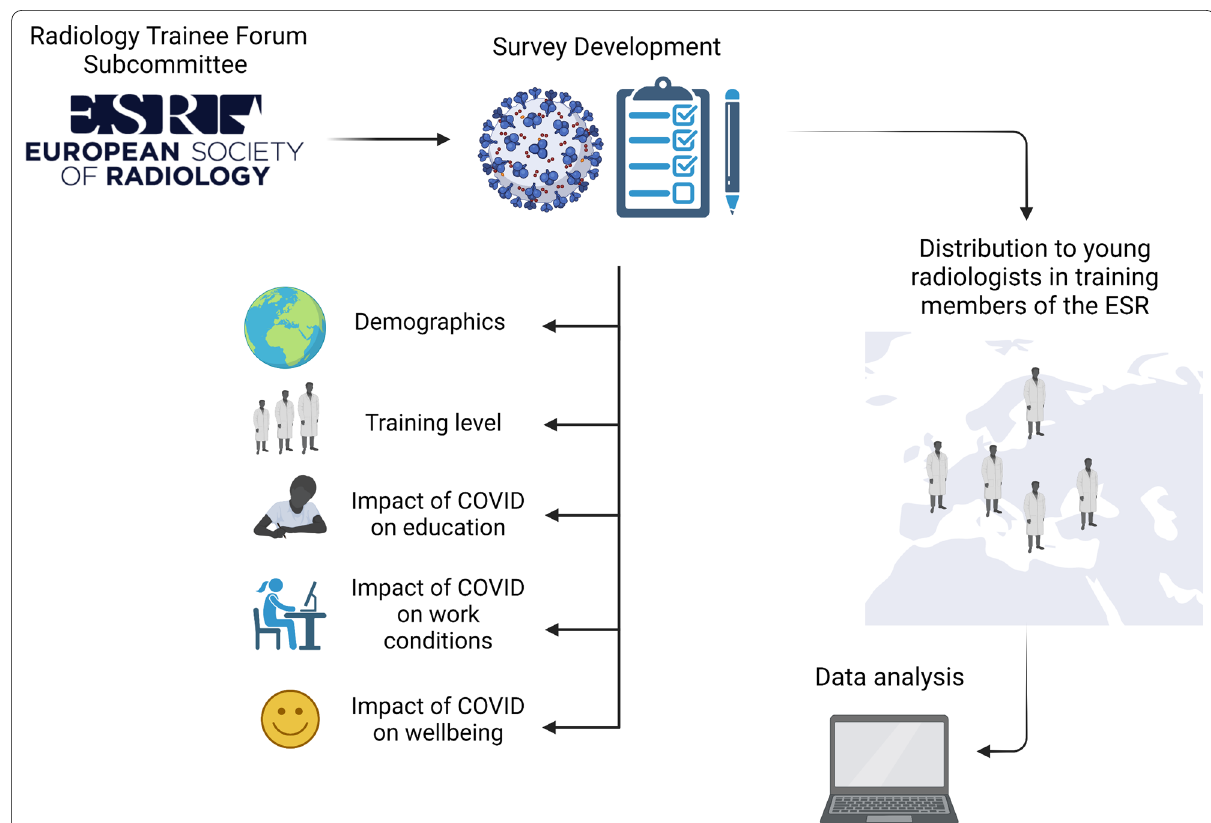
Fig. 1 Flowchart describing the process of questionnaire development and data collection on the impact of COVID-19 on radiology training of young trainee members of the European Society of Radiology (ESR) (created with